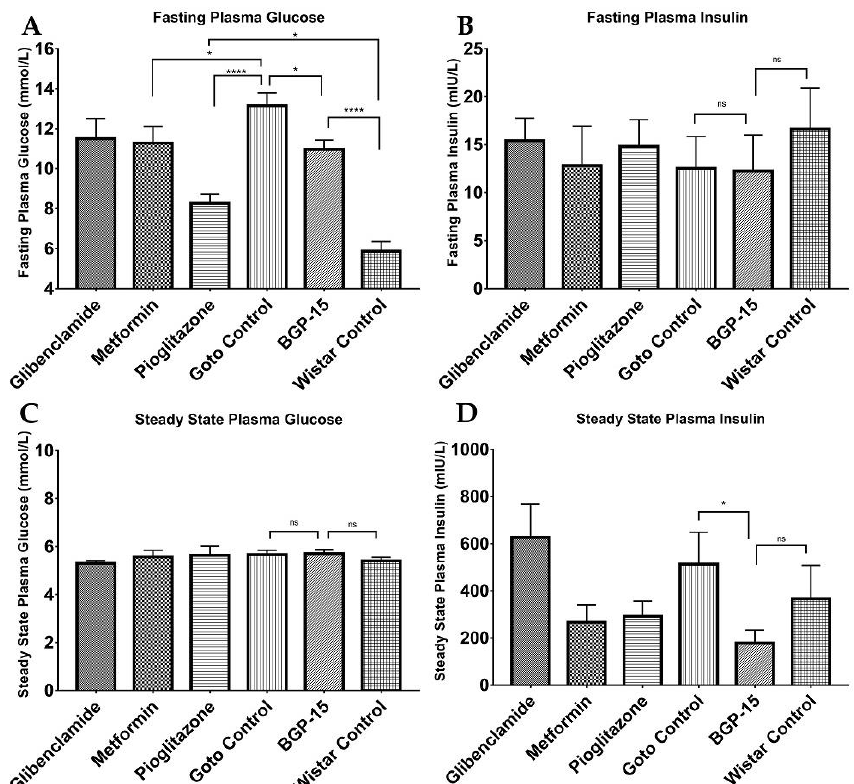
Figure 7. Plasma glucose and insulin values at the start and at the end of hyperinsulinemic euglycemic glucose clamp (HEGC) protocol. ( A ) Fasting plasma glucose values at the start of the HEGC protocol; ( B ) Fasting plasma insulin values at the start of the HEGC protocol; ( C ) Steady state plasma glucose values at the end of the HEGC protocol; ( D ) Steady state plasma insulin values at the end of HEGC protocol. All data are presented as mean ± standard error of the mean (SEM). n = 6 animals in each group. * p < 0.05; **** p < 0.0001; ns = non-significant. Statistical analysis was done using GraphPad Prism: after estimation of Gaussian distribution with Shapiro-Wilk normality test data was either analysed with one-way analysis of variance (ANOVA) or non-parametric Kruskal-Wallis